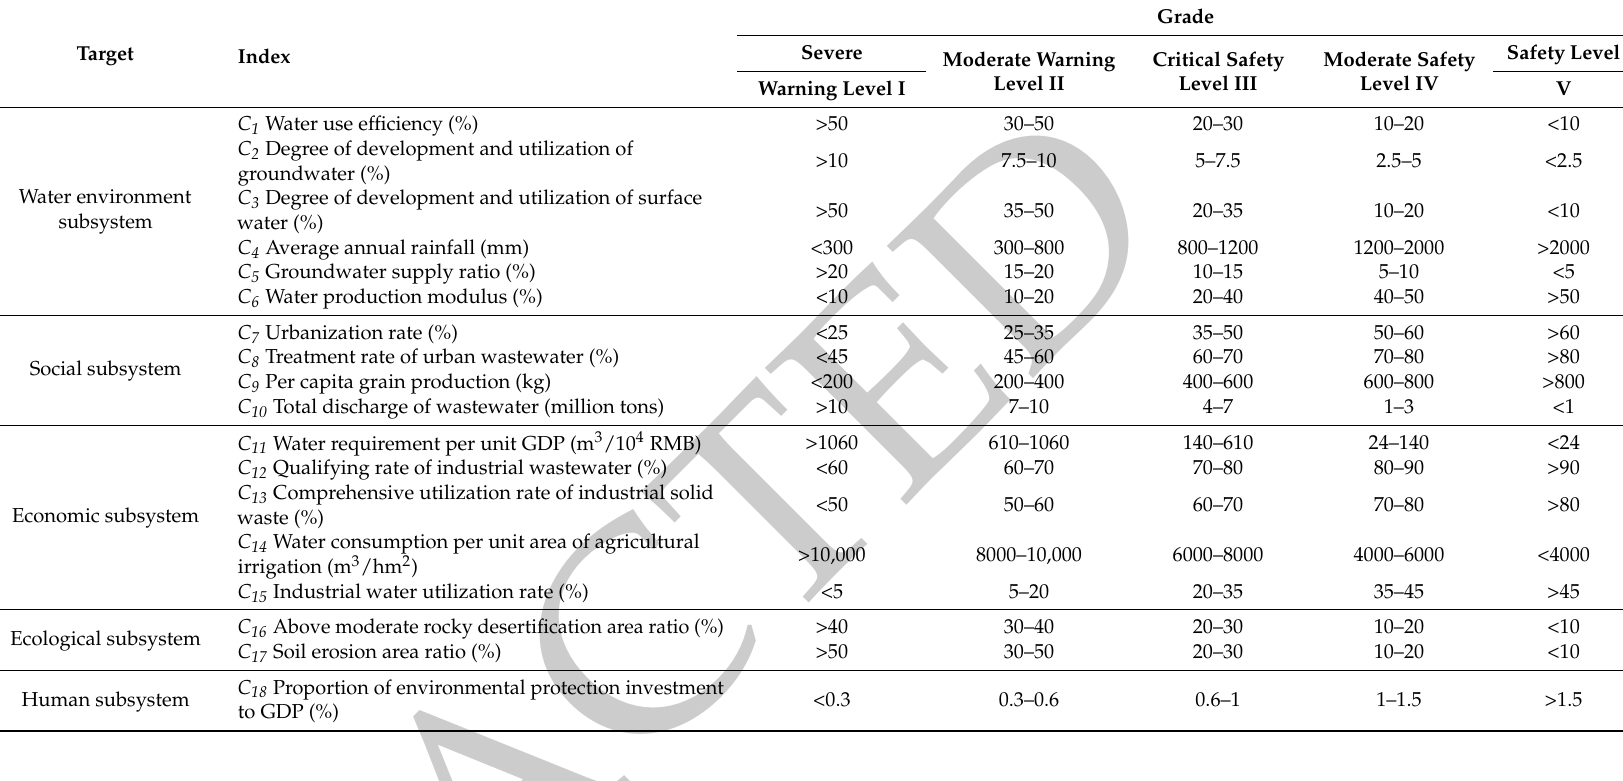
Table 3. Grade classification of water resource security in the karst